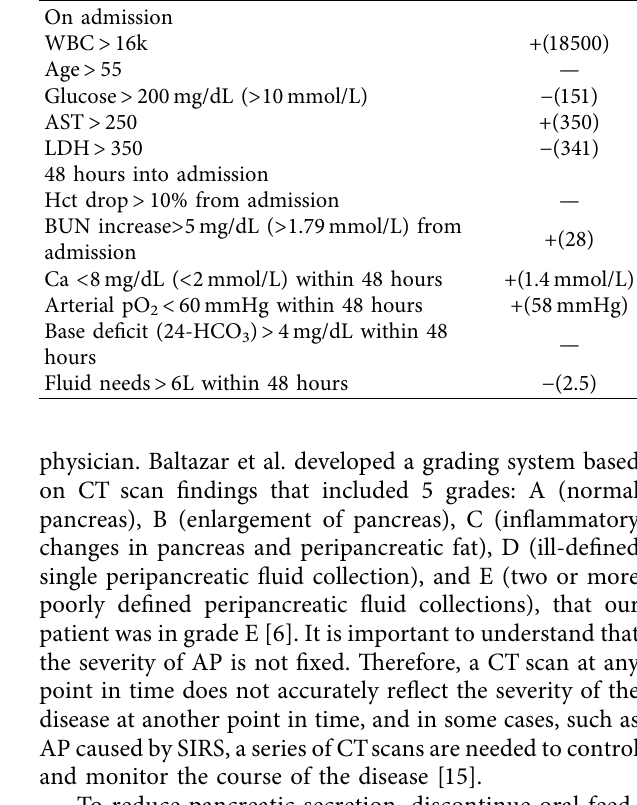
Table 2: Ranson criteria for our patient. Criteria Our